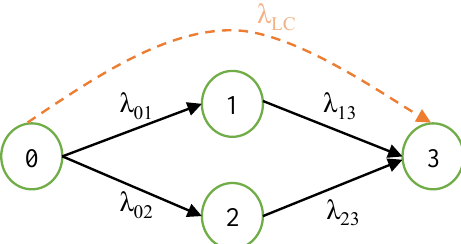
Figure 3. Markov-chain diagram of the whole fault-tolerant converter system. The subsystem defined by the capacitors and inductors is represented in dashed